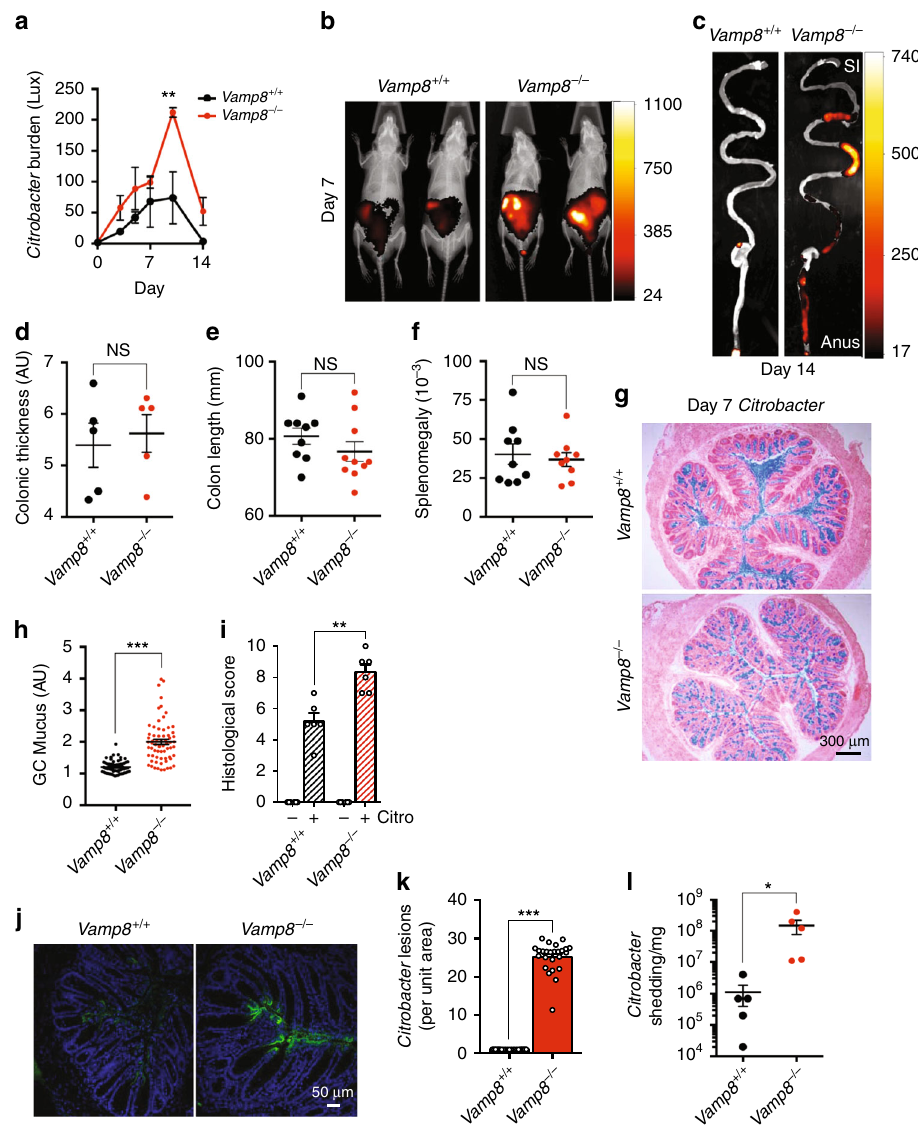
Fig. 7 Vamp8 − / − littermates are more susceptible to infectious colitis. a Mice were infected with bioluminescent Citrobacter rodentium for 14 days and bacterial burden in intact animals assessed by whole body imaging (two independent experiments, four mice per group). b Representative images of Vamp8 + / + and Vamp8 − / − are shown at Day 7. c At day 14-post infection, mice were sacri fi ced and intestines imaged ex vivo. Gross pathology markers including colonic thickness d , colon length e , and splenomegaly f were measured in mice infected with Citrobacter at day 7 post infection (two independent experiments, fi ve mice per group). g Carnoy ’ s fi xed colon was processed for histology and stained with Alcian blue to visualize goblet cell and luminal mucin (blue) at day 7-post infection (two independent experiments, >3 mice per group, scale bar 300 μ m). h The number of Alcian blue positive goblet cells was enumerated from multiple ROIs by surface area in Vamp8 + / + and Vamp8 − / − following Citrobacter infection (pooled from two independent experiments, >3 mice per group). i Histological scoring of Citrobacter- infected colonic tissue sections was performed based on mucosa thickening, epithelial cell erosion, edema, and in fl ammatory cell in fi ltrate (pooled from two independent experiments, >3 mice per group). j Citrobacter bound to epithelial cells and producing attaching and effacing lesions was visualized by confocal staining of colon tissues at day 7-post infection (two independent experiments, three mice per group, scale bar 50 μ m). k The abundance of attaching and effacing lesions was quanti fi ed from confocal images based on ROIs by surface area (pooled from two independent experiments, three mice per group, >4 ROIs per mouse). l Citrobacter shedding into the stool was quanti fi ed by enumerating CFU at day 7-post infection (representative data from one experiment repeated two independent times, fi ve mice per group). Bars indicate mean ± standard error of the mean. * P < 0.05, ** P < 0.01, unpaired two-tailed Student's T -test a , d – f , h , i , k ,